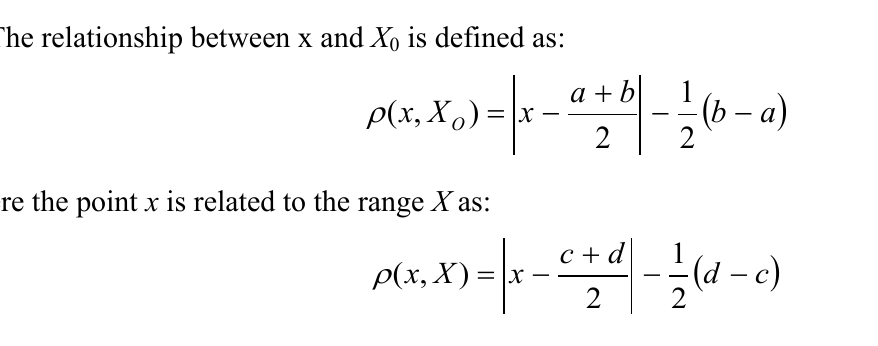
Figure 12. An extension correlation